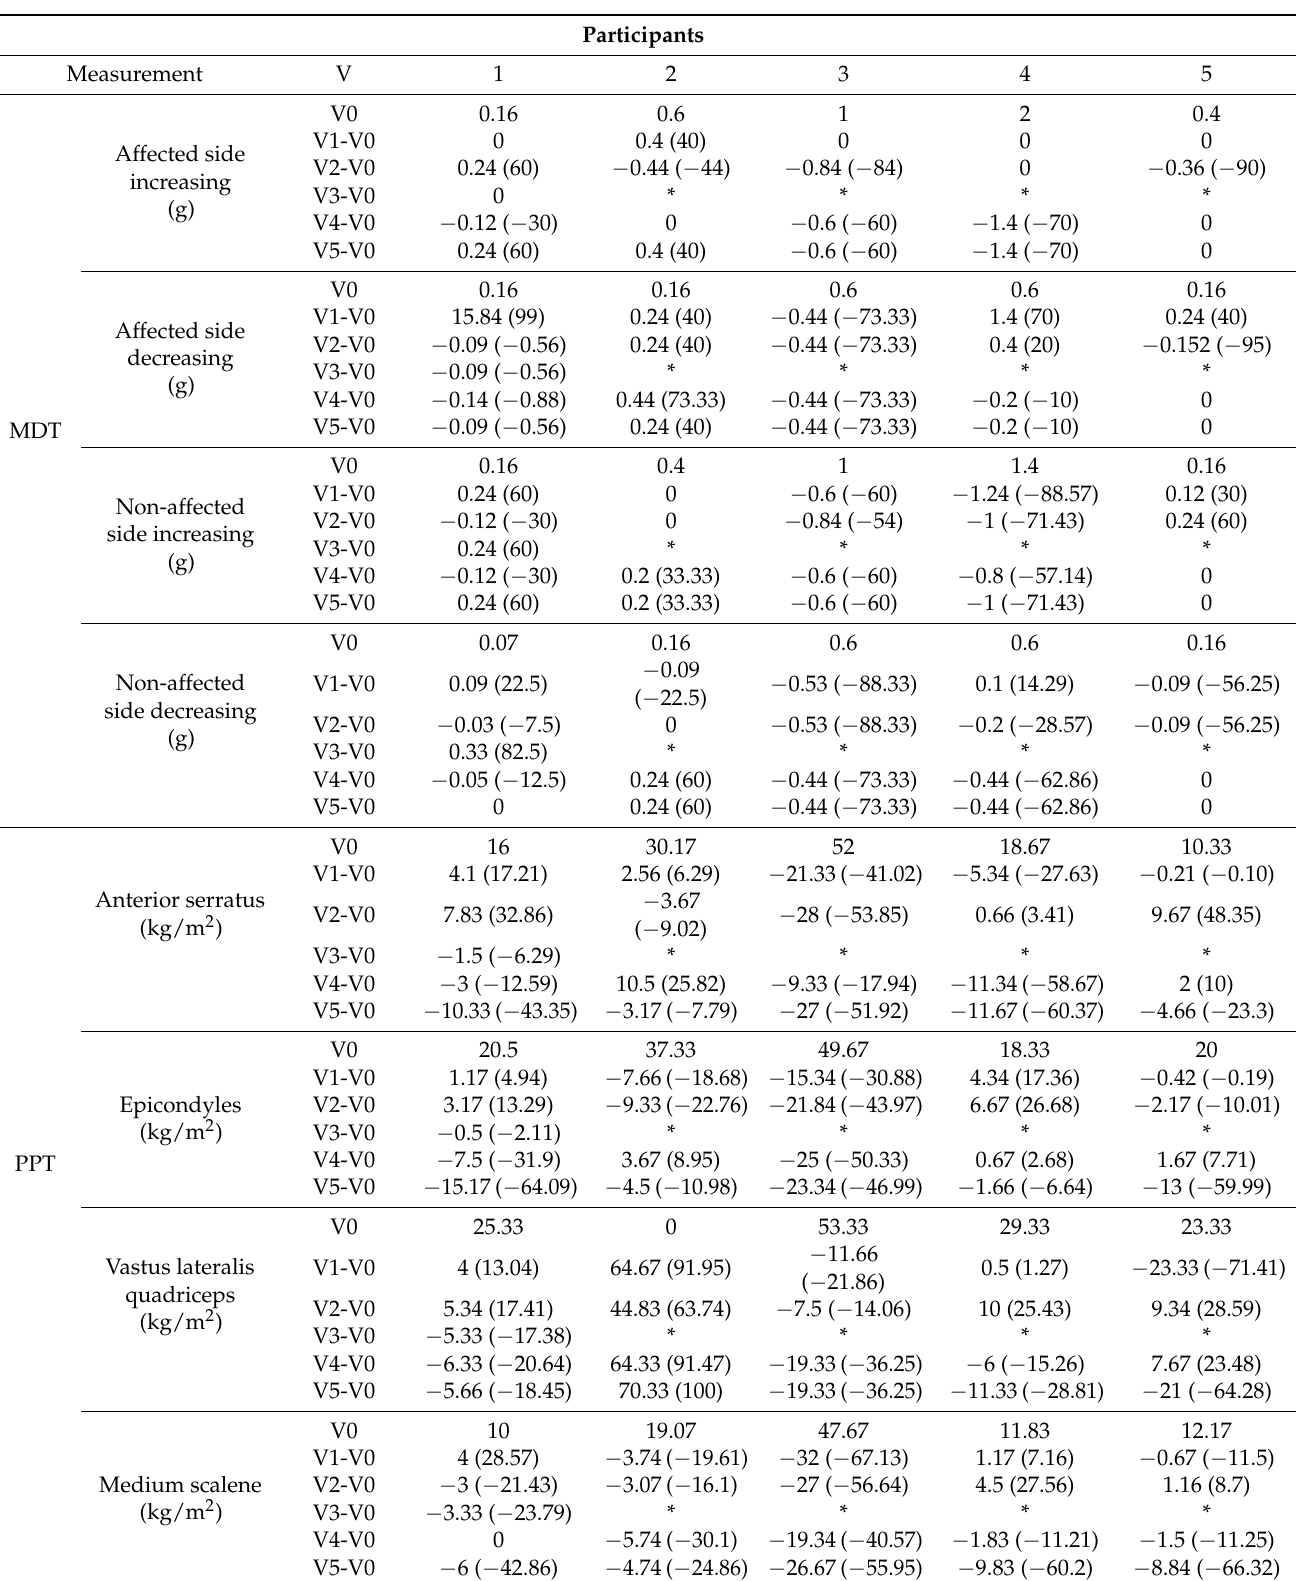
Table 4. Changes (percentage) in direct measurements scores: mechanical detection threshold and pressure pain